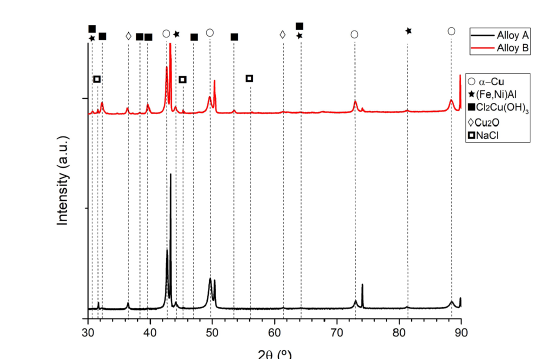
Figure 8. XRD of the NAB alloy A and NAB alloy B samples after electrochemical corrosion tests with their corresponding corrosion by-products.